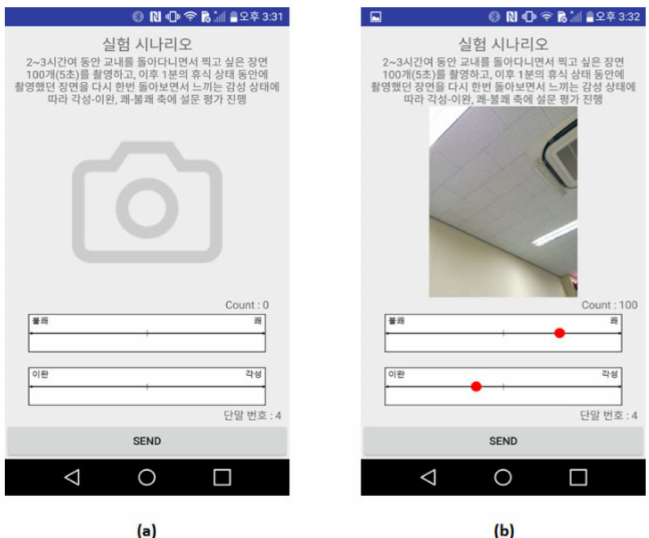
Figure 7. Developed Android application for capturing the surrounding environment and performing the subjective emotional evaluation. ( a ) The initial screen; ( b ) Screen after capturing video and subjective